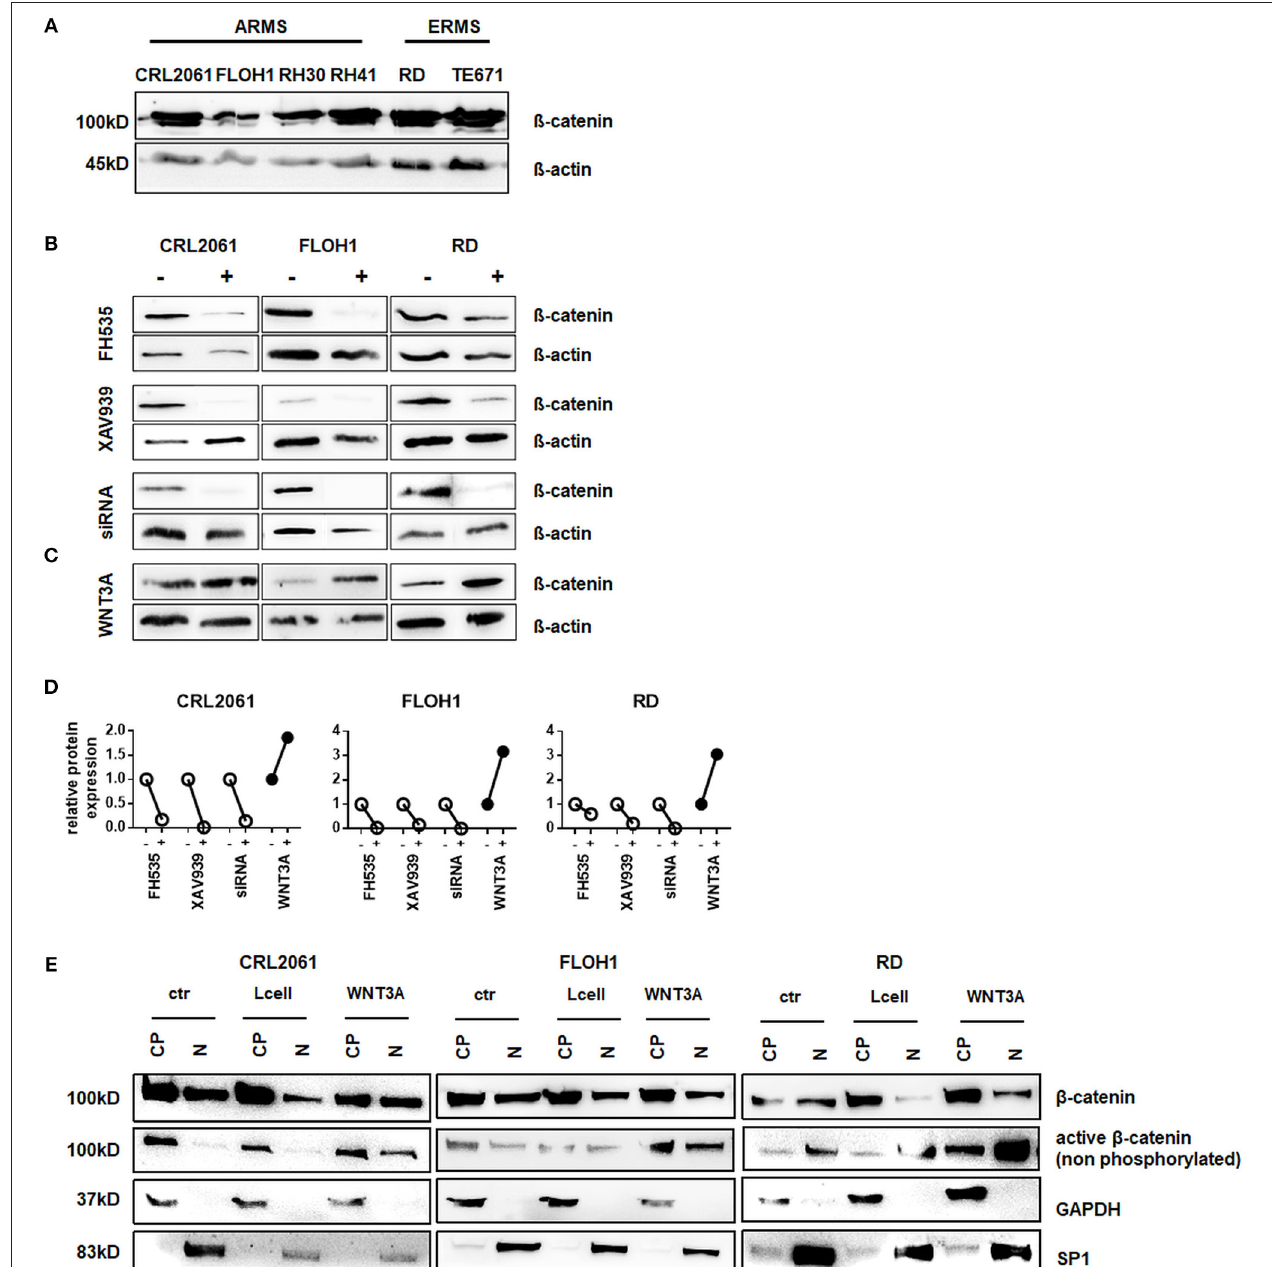
FIGURE 1 | Western Blot analysis of β -catenin expression in RMS tumor cell lines. (A) Western Blot analysis of ß-catenin expression in various RMS tumor cell lines. ß-actin served as loading control. (B) Western Blot analysis of ß-catenin expression in three different RMS tumor cell lines after 48h treatment with either FH535, XAV939, ß-catenin siRNA, or (C) WNT3A treatment. ß-actin served as loading control. (D) Densitometric quantification of the Western Blots shown in (C) using ImageJ. Expression of ß-catenin after treatment ( + ) was normalized to ß-actin and compared to untreated cells ( − ). (E) subcellular localization of ß-catenin in the RMS tumor cell lines with and without WNT3A stimulation. GAPDH served as cytoplasmatic and SP1 as nuclear marker to check purity of the protein isolation from different compartments. CP, cytoplasmatic; N,